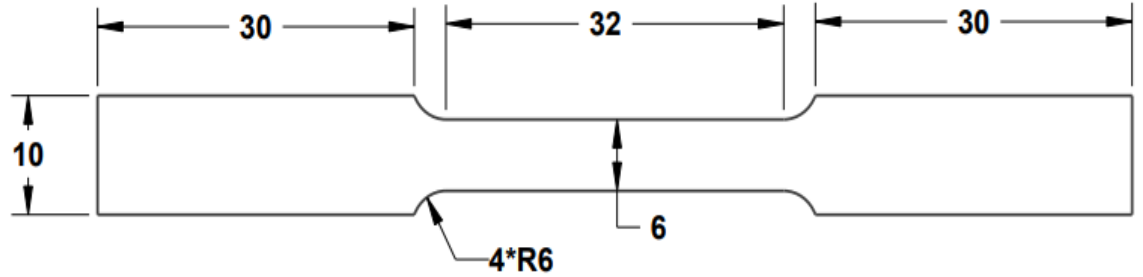
Figure 2. The geometry of tensile test specimens is based on the standard.